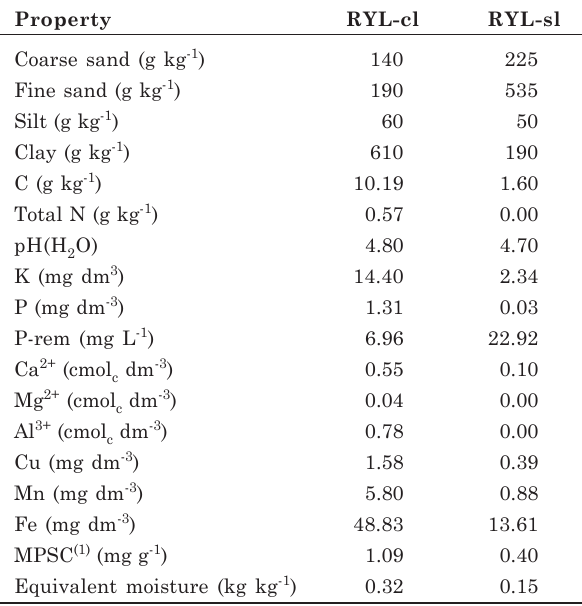
Table 1. Physical and chemical properties of a